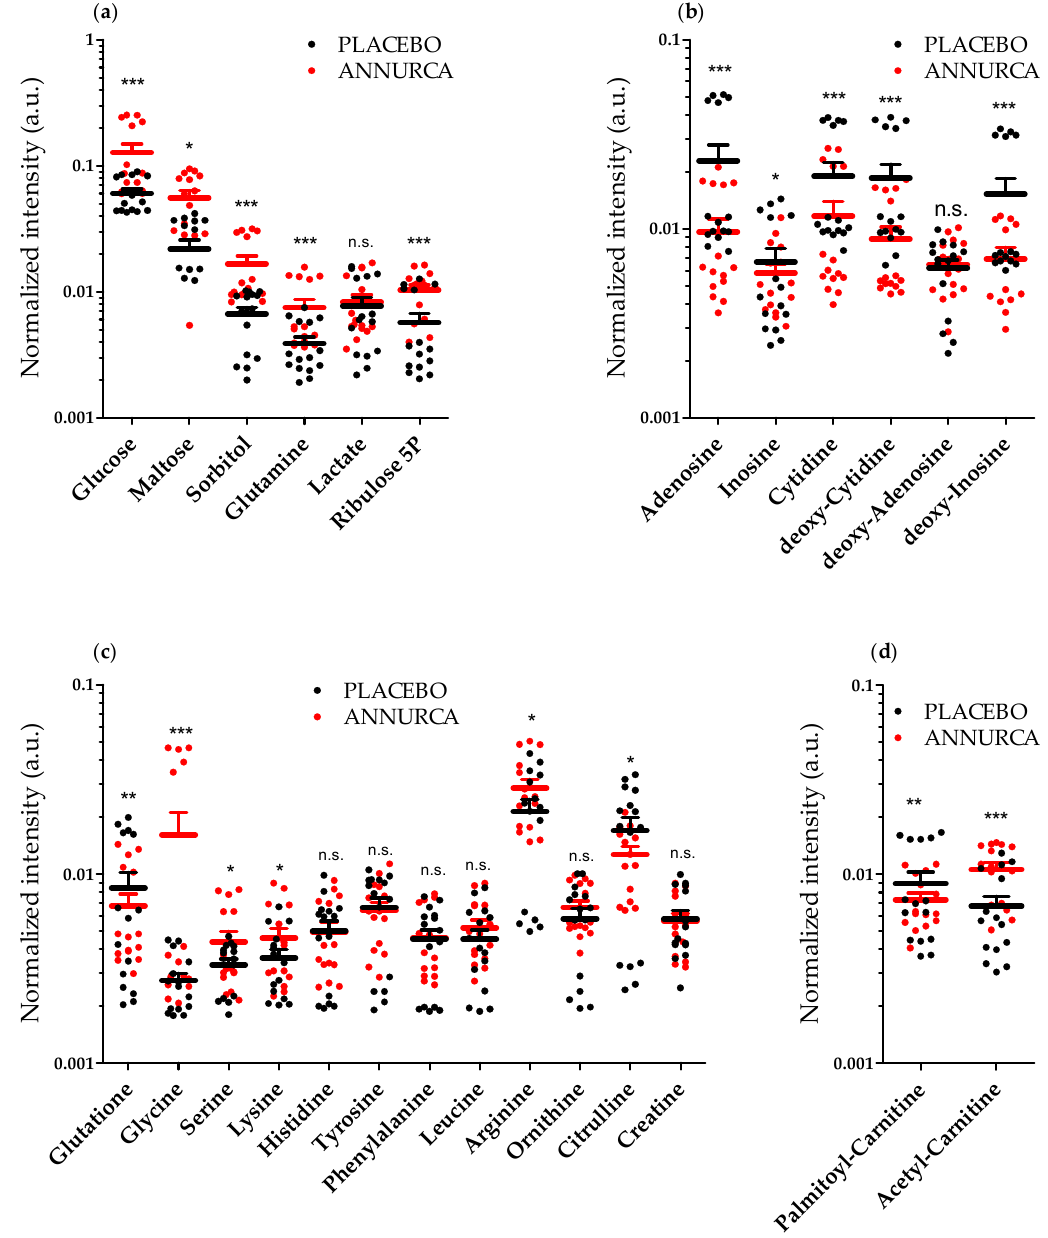
Figure 2. AAE diverts HF metabolic pathways from PPP and amino acid oxidation. Metabolomic analysis (Carbohydrates ( a ); nucleotides (b); amino acids ( c ); carnitine derivatives ( d )) of HF cells extracted from C57BL/6 mice treated topically for 4 weeks with a foam containing AAE (red dots, ANNURCA) or a Placebo (black dots PLACEBO). Each point represents the normalized intensity of the metabolite ( n = 15 measurements, mean ± SEM. Two way ANOVA and Bonferroni post-test analysis were performed; * = p < 0.05; ** = p < 0.01; *** = p < 0.001; n.s.: non statically different). The effect exerted by AAE on the intracellular levels of glutamine and glycine reflects that observed for other amino acids (Figure 2c). We measured an increase in the intracellular levels of arginine (1.3 ± 0.2-fold, p < 0.05), serine (1.3 ± 0.2-fold, p < 0.05), and lysine (1.3 ± 0.2-fold, p < 0.05). Differently, the intracellular level of histidine (1.0 ± 0.1-fold, p > 0.05), tyrosine (1.0 ± 0.1-fold, p > 0.05), leucine (0.9 ± 0.1-fold, p > 0.05) and phenylalanine (1.0 ± 0.1-fold, p > 0.05) were not statistically